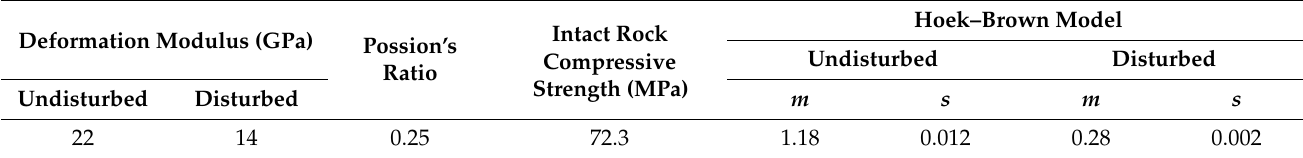
Table 1. Rock mass parameters calibrated from the triaxial tests.